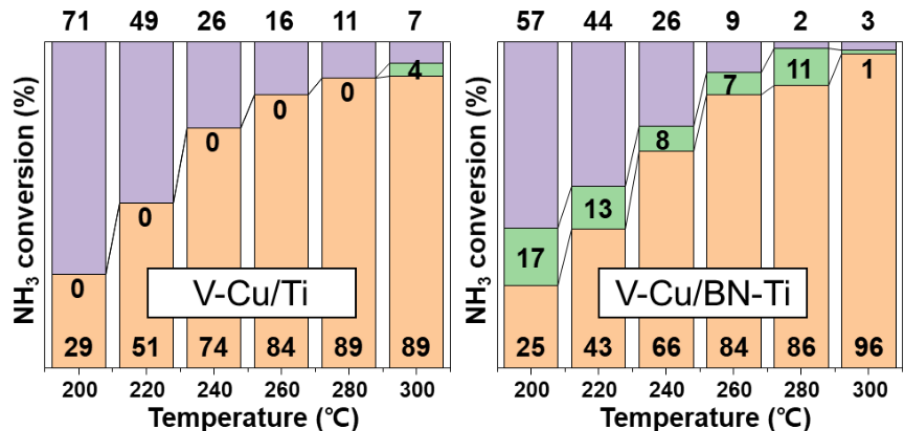
Figure 7. Catalytic performance with SO 2 in ( a ) NO X conversion, N 2 selectivity, and ( b ) NH 3 conversion of the synthesized catalysts. Gas conditions were [NO X ] = [NH 3 ] = 300 ppm, [SO 2 ] = 100 ppm, [O 2 ] = 5 vol. %, [N 2 ] = balance, total flow = 500 mL/min, and gas hourly space velocity (GHSV) = 60,000 h − 1 . The performance of all the catalysts tended to decrease because NH 3 was not used as a reducing agent in the NH 3 -SCR reaction in the presence of SO 2 , which caused a reduction in the proportion used for SCR and SCO. Nevertheless, V-Cu/BN-Ti increased the selective